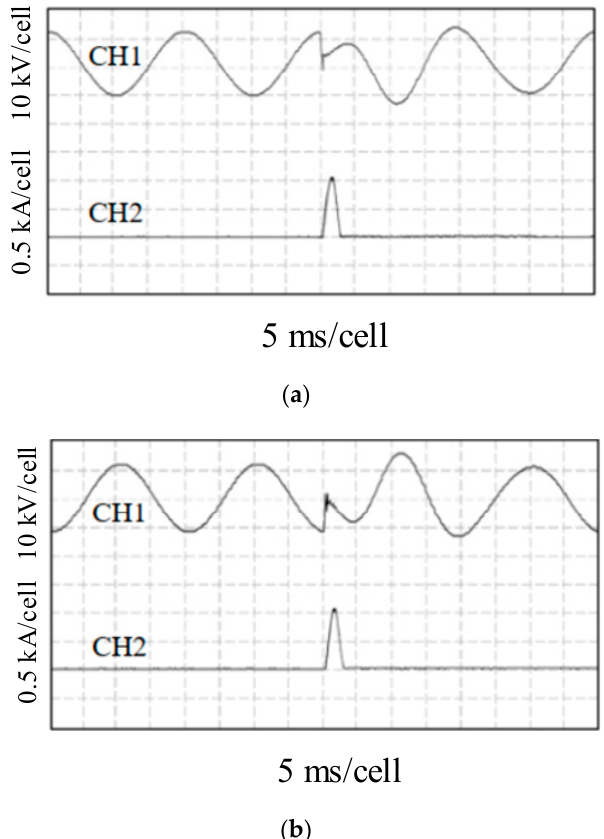
Figure 7. Test object voltage and current waveforms. ( a ) Positive polarity triggers the inrush voltage of the working frequency voltage; ( b ) negative polarity trigger shock voltage of the industrial frequency voltage.